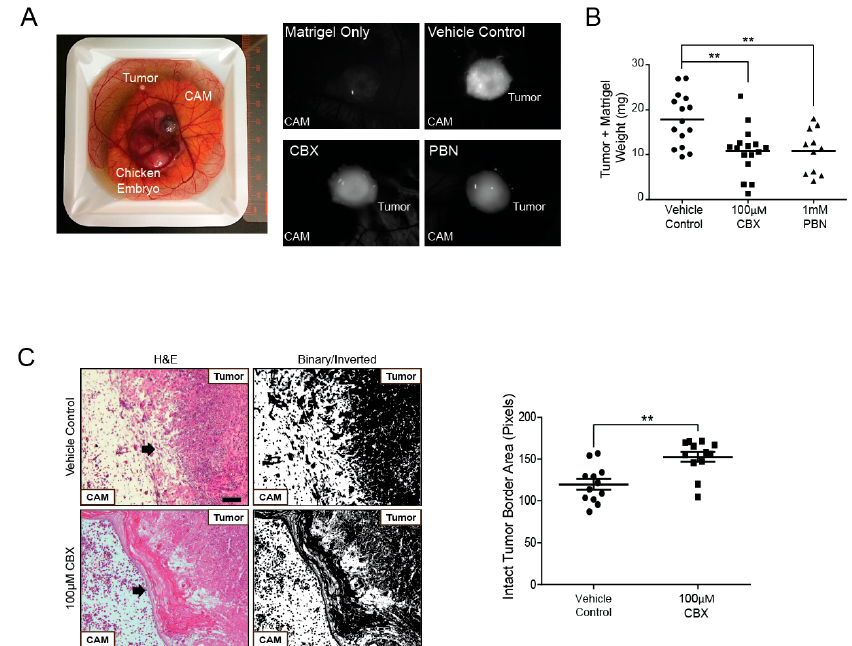
Figure 6. PANX1 blockers significantly reduced A375-MA2 melanoma tumor weight and invasion in chicken embryo xenografts. ( A ) One million A375-MA2 human melanoma cells were incubated with a DiO’lipophilic cell tracer, combined with Matrigel (1:1) and seeded onto the chorioallantoic membrane (CAM) of a ten-day-old chick embryo ex vivo. A375-MA2 tumors treated for one week with 100 μ M CBX (N = 16) or 1 mM PBN (N = 11). ( B ) Tumors treated with CBX or PBN weighed